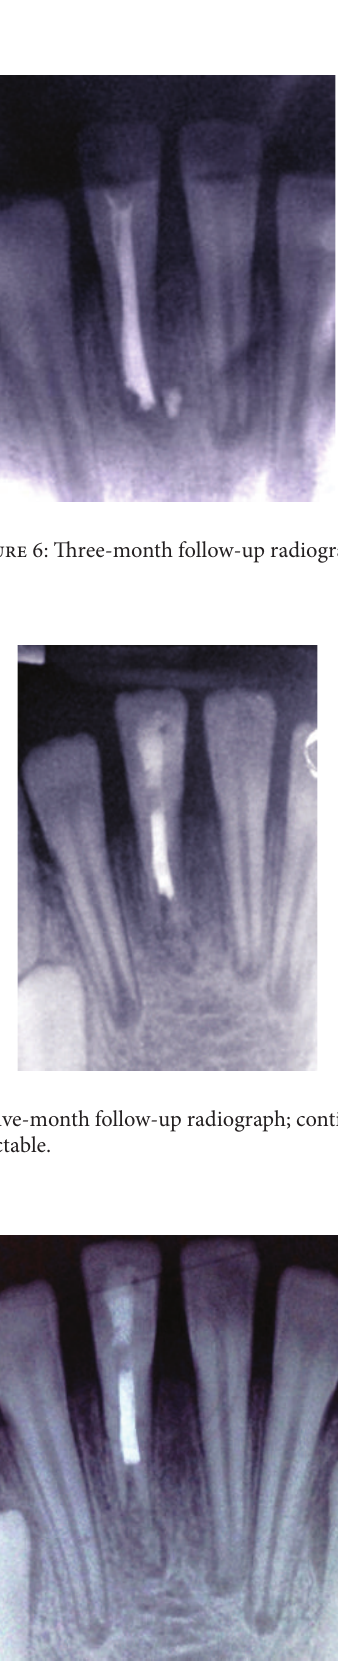
Figure 5: One month follow-up radiograph.